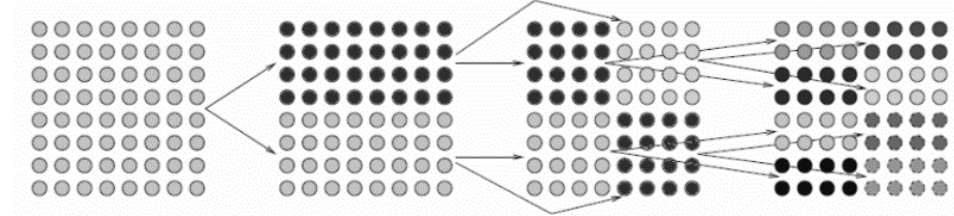
Figure 2. A schematic diagram of a typical H-matrix structure. Black represents full matrix blocks and white represents low-rank matrix blocks.